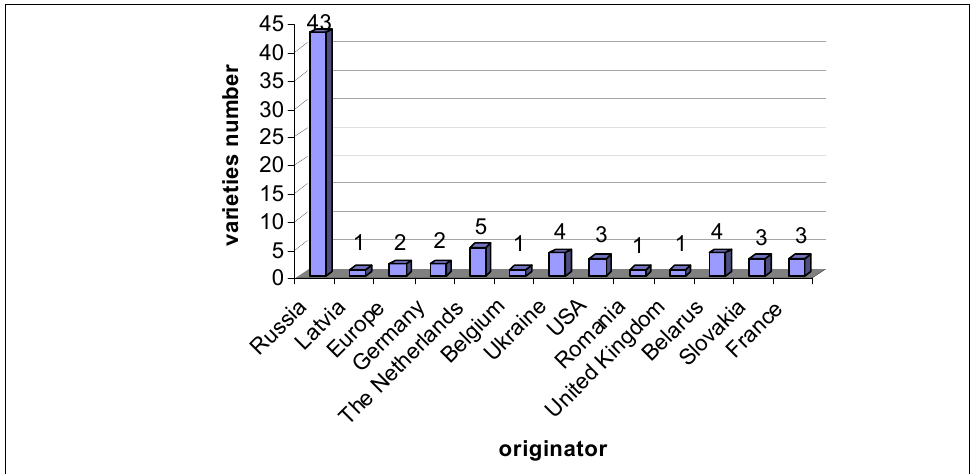
Figure 1. Countries of origin of the 73 cultivars involved in the analysis.